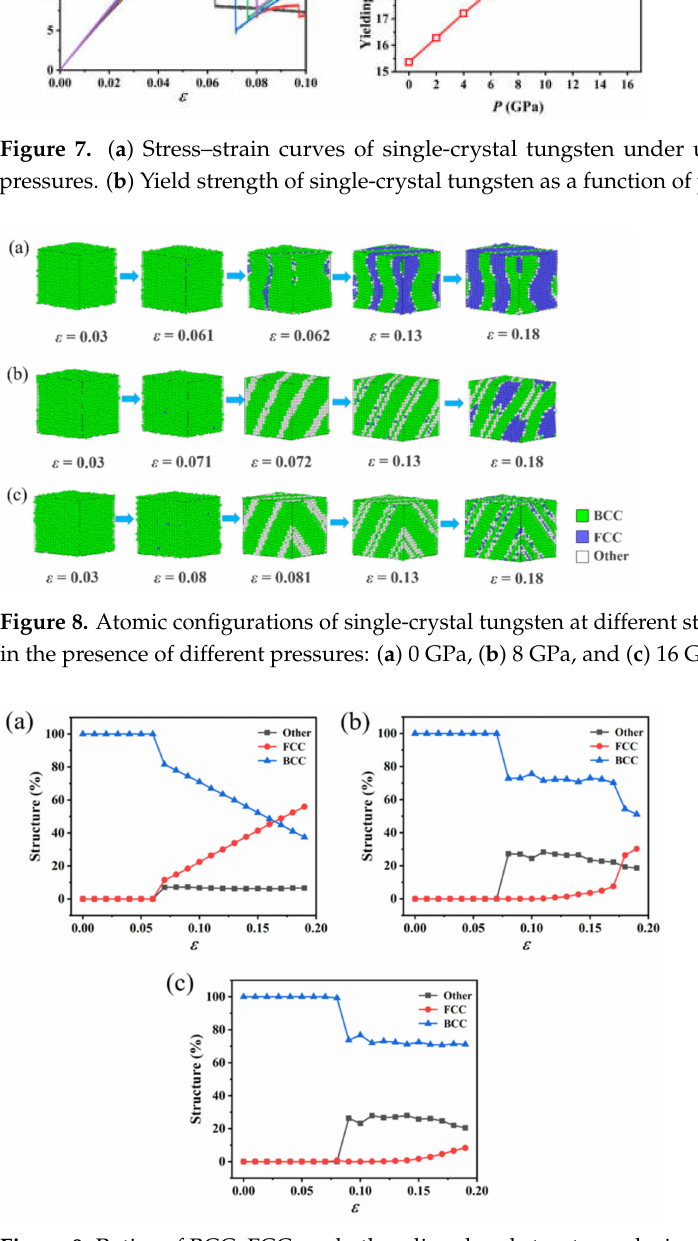
Figure 9. Ratios of BCC, FCC, and other disordered structures during uniaxial tension at different pressures: ( a ) 0 GPa, ( b ) 8 GPa, and ( c ) 16